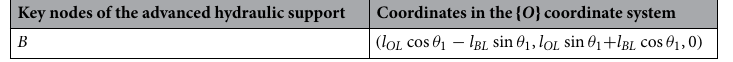
Table 2. Coordinates of node B in the { O } coordinate system.